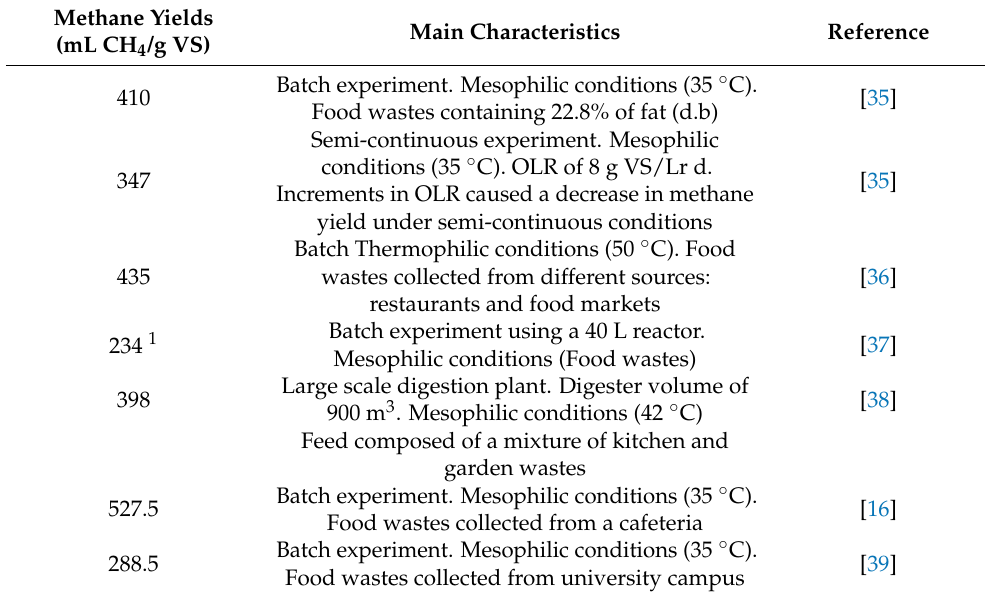
Table 4. Results reported in the literature regarding methane yields obtained from food wastes un- der different operating conditions.